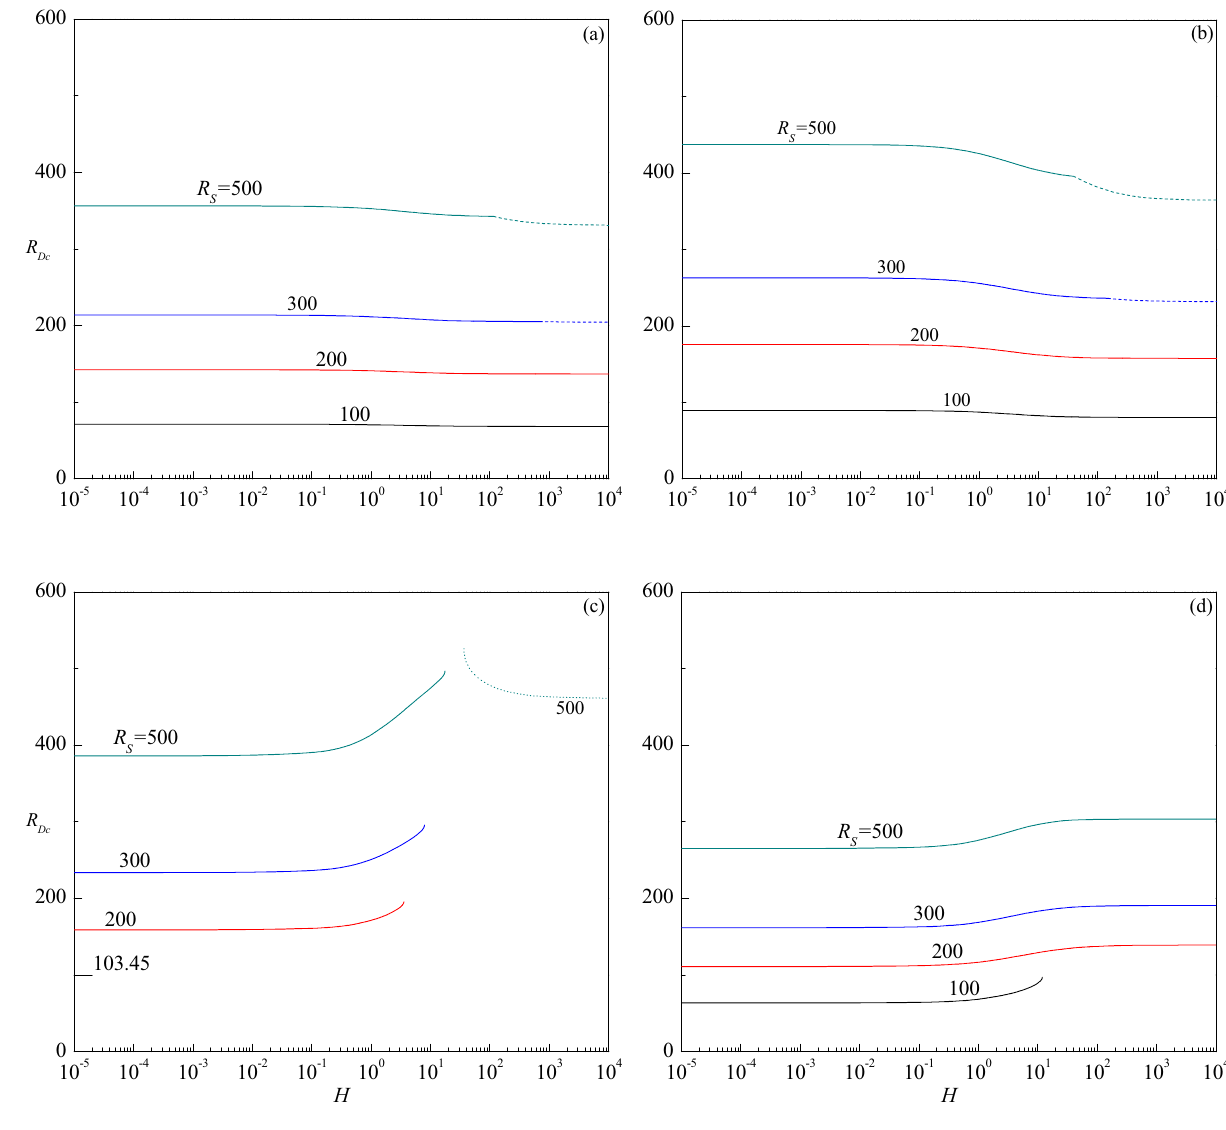
Figure 6. The variation of R Dc versus H for different values of R S relative to the cases ( a ) Le = 10 , ( b ) Le = 2 , ( c ) Le = 0.5 and ( d ) Le = 0.1 , when γ = 1